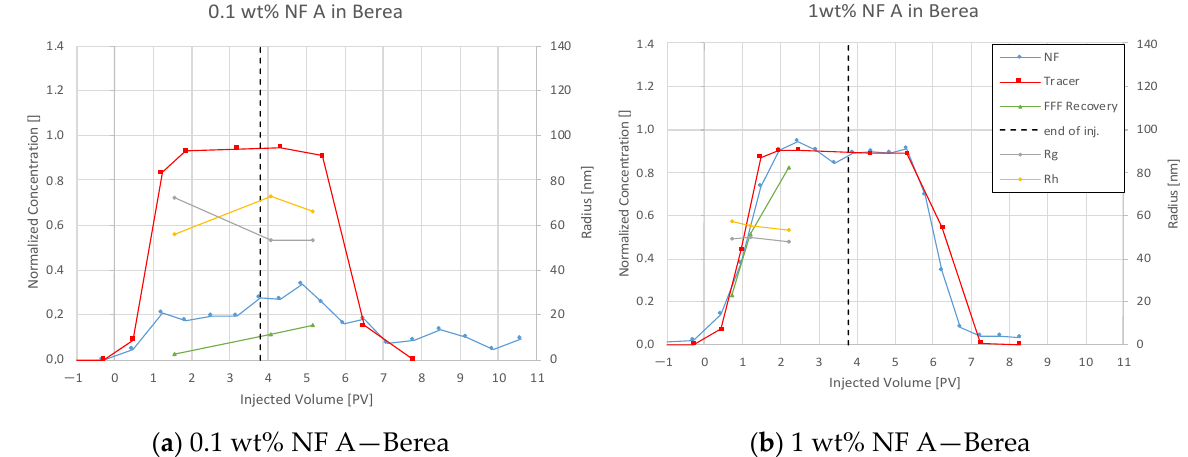
Figure 7. Effluent analysis for 0.1 wt% ( a ) and 1 wt% ( b ) NF A in TW in Berea sandstone. For the low concentration injections, high adsorption is seen for NF A, whereas the tracer seems to pass the core unaffected. During the high concentration injection of NF A, the effluent concentration follows the tracer concentration better, indicating no further adsorption. Particle size measurements confirm the low NF recovery (green) and larger particles arriving earlier in the effluent.